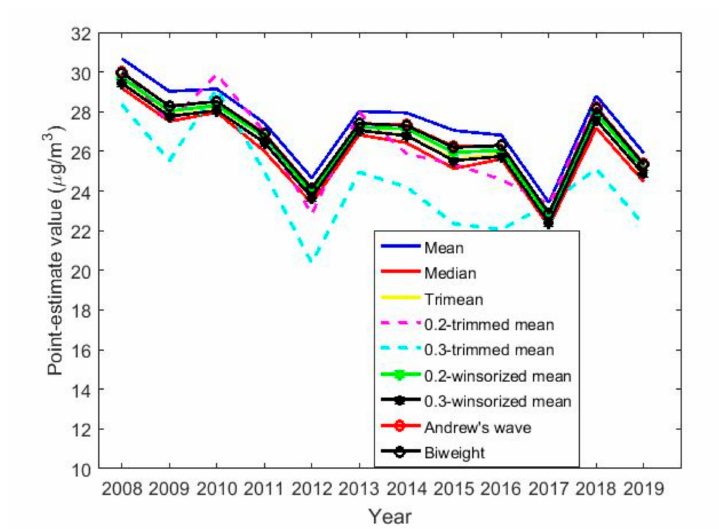
Figure 15. Graphical representation of the location estimates for the twelve years under study. Location estimators: mean, median, trimean, 0.2-trimmed mean, 0.3-trimmed mean, 0.2-winsorized mean, 0.3-winsorized mean, Andrew’s wave, and biweight.